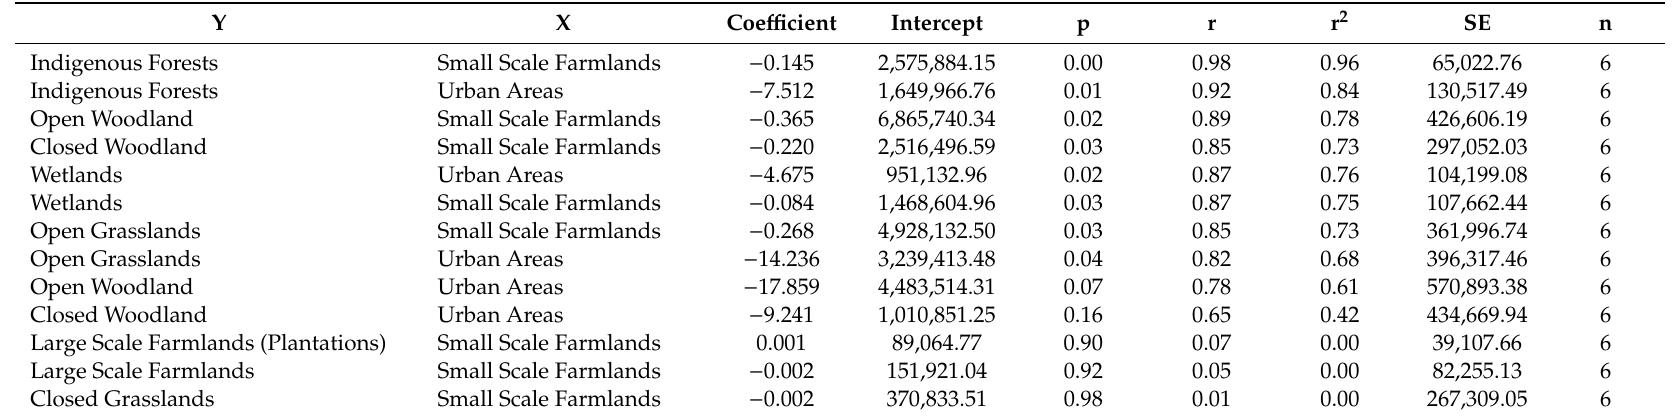
Table 3. Model parameters for linear regressions run for area combinations of various land cover types: p (p-value); r (correlation coe ffi cient); r 2 (regression coe ffi cient); SE (standard error); n (number of